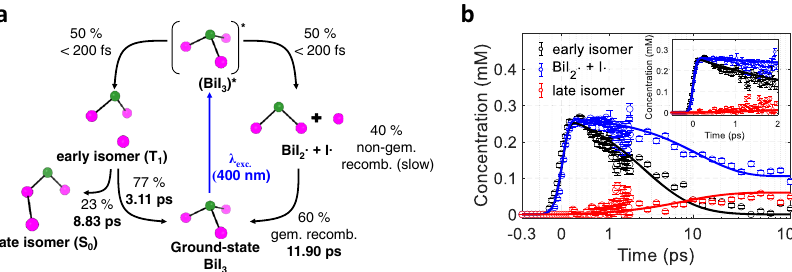
Fig. 3 Kinetic model, temporal concentration pro fi les of reacting species of BiI 3 . a Kinetic model for the photochemistry of BiI 3 revealed in this work. Upon 400nm excitation, BiI 3 undergoes isomerization to the early isomer and dissociation to radical fragments, BiI 2 • and I • . The early isomer subsequently relaxes to the late isomer and ground-state BiI 3 , while a portion of the radical fragments to the ground-state BiI 3 through geminate recombination (gem. recomb.). The remaining radical fragments stay almost unreacted within the probed time range due to the slow rate of non-geminate recombination (non- gem. recomb.). b The concentration pro fi le of reacting species corresponding to the kinetic model shown in ( a ). The inset shows the early-time concentration pro fi le up to 2 ps in a linear time scale. The solid lines were obtained from the global fi t analysis of Δ S iso ’ ( q , t ) based on the kinetic model shown in a and the dots with one-standard-deviation error bars were obtained by independently fi tting the individual experimental data with a linear combination of solute, cage, and solvent